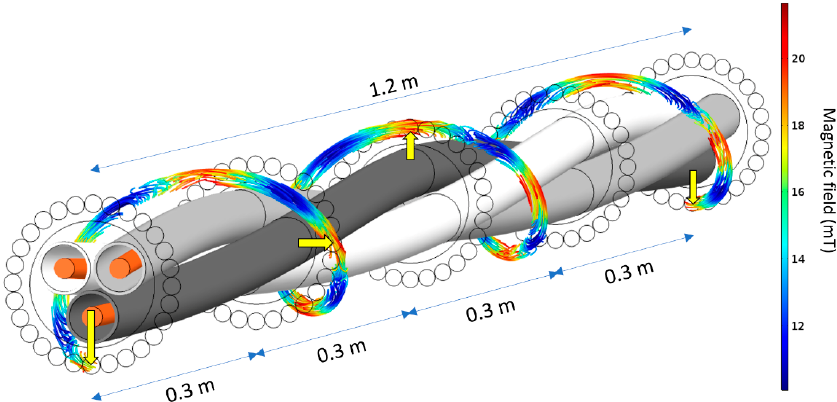
Figure 6. Magnetic flux lines through an armor wire in Cable 1. The arrows indicate the crossing points between the armor and a particular phase.